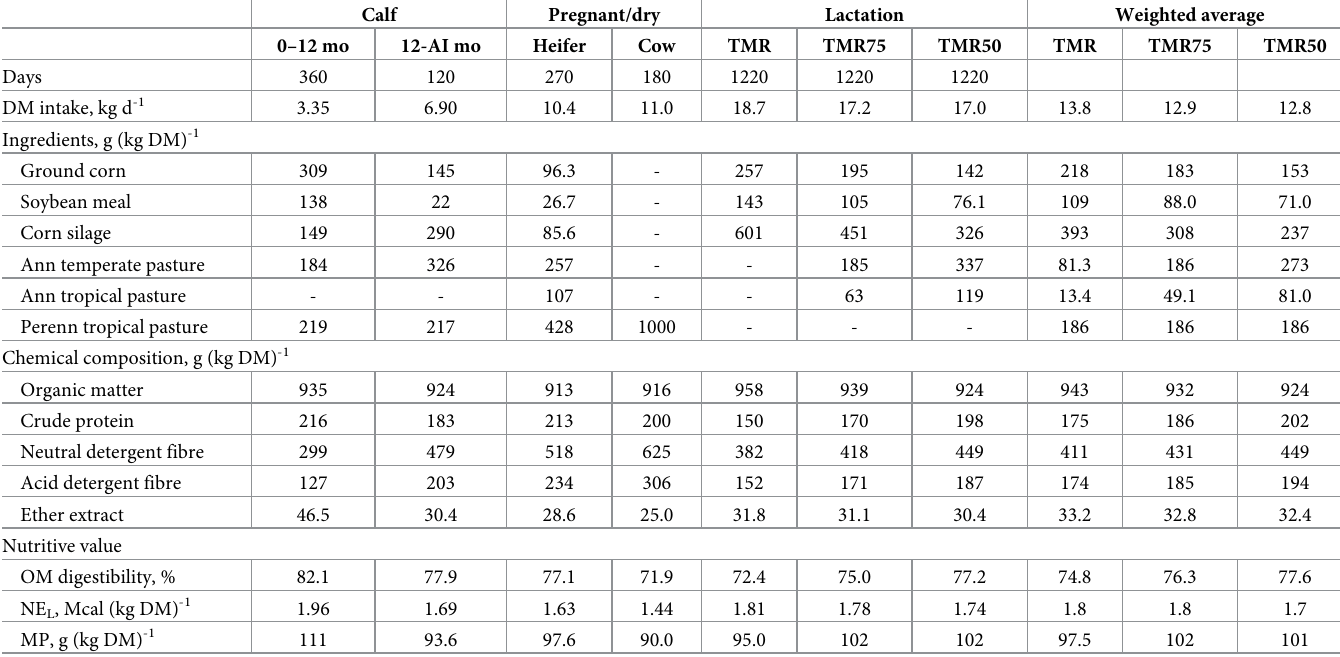
Table 2. Dairy cows’ diets in different scenarios a